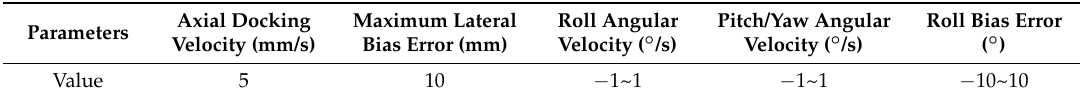
Table 2. Initial docking conditions of